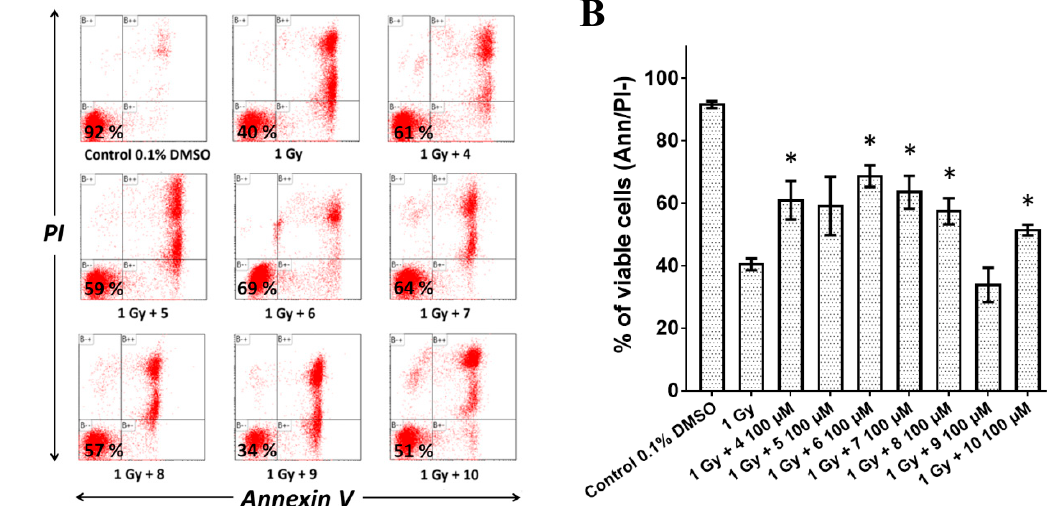
Figure 2. The viability of MOLT-4 cells after exposed to ionizing radiation (IR) alone or in combination with inhibitors at 100 µM. Viability of MOLT-4 cells was determined as the percentage of Annexin-V–Alexa Fluor ® 488 and propidium iodide (PI)-negative cells by flow cytometry 24 h following irradiation with a dose of 1 Gy. ( A ) Representative flow cytometry histograms depicting the percentage of viable MOLT-4 cells are shown. ( B ) The bar graph represents the percentage of viable MOLT-4 cells detected by flow cytometry. Results are shown as the mean ± SD from four experiments. *—significantly different from irradiation alone (t-test, * p < 0.05).